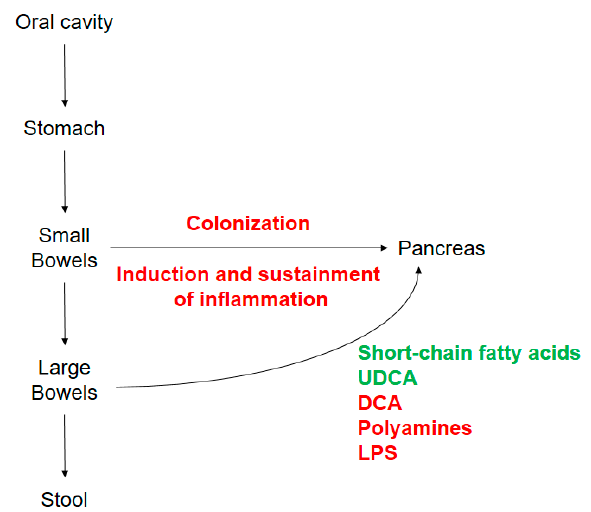
Schematic representation of the role of oncobiosis in pancreatic adenocarcinoma. Rows represent the spillover of the dysbiotic microbiome of the oral cavity, stomach, and bowels to the pancreas and feces. Antineoplastic processes are shown in green and neoplastic processes are shown in red. Abbreviations: UDCA—ursodeoxycholic acid, DCA—deoxycholic acid, LPS— lipopolysaccharide.